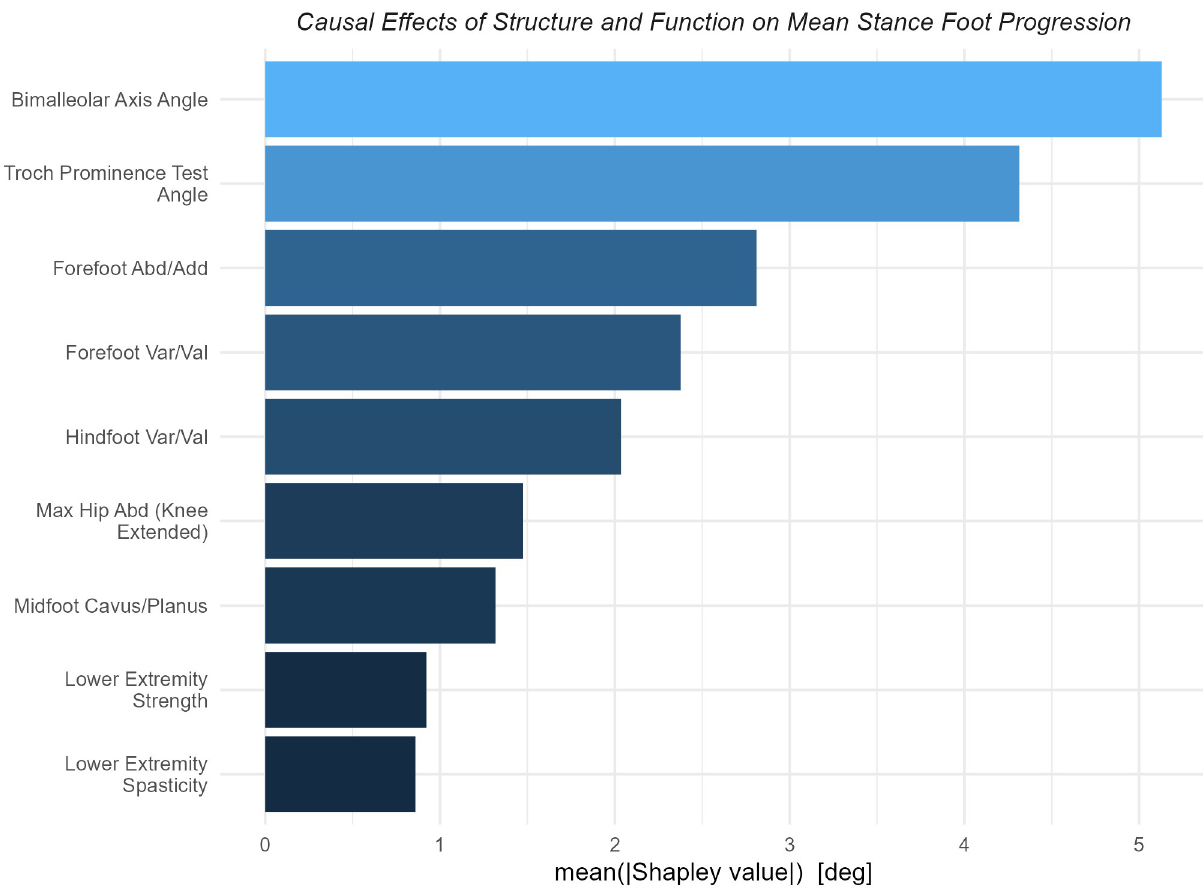
Fig 2. Importance of Structure and Function on mean stance foot progression. The nine variables with the largest absolute Shapley values for mean stance foot progression are shown. Unsurprisingly, torsions of the tibia and femur are the two largest contributors to mean stance foot progression. Foot deformities comprise the next three largest